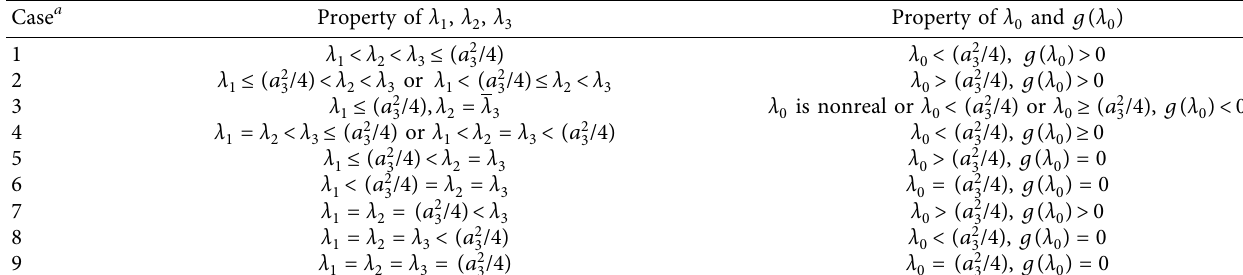
Table 3: Properties of λ